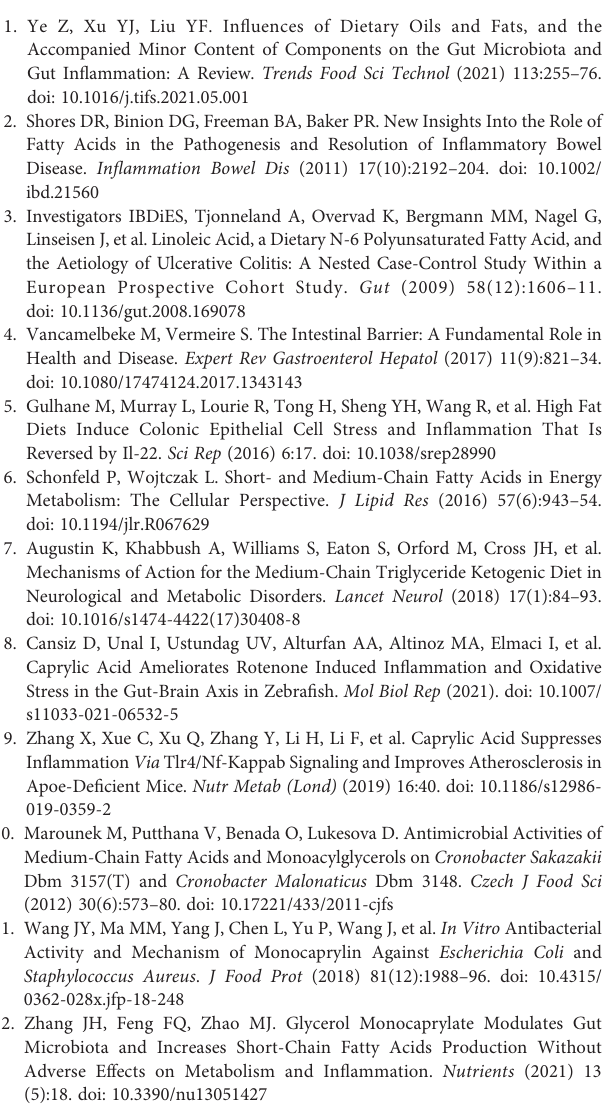
accumulation boxplot (F) of content fl ora both tended to approach the saturation plateau (n=4). The pro fi le of content fl ora (n=4) (G – O) . The histogram of relative abundance of phylum (G) and genus (H) (Only top 10 most abundant (based on relative abundance) bacterial phyla and genera were shown. Other phyla and genera were all assigned as ‘ Others ’ .) were calculated to portray the fundamental structure of content fl ora. The ratio of Firmicute to Bacteroidetes (n=3) (I) was calculated to portray the fundamental structure of gut content fl ora. Alpha diversity indices included the Simpson index (J) , the Shannon index (K) , the Chao 1 index (L) , and the abundance-based coverage estimator (Ace) index (M) were calculated to compare the community diversity and richness. The beta diversity analyses were performed on the weighted Unifrac distance matrix to analyze the extent of similarities in microbial communities, including the principal coordinates analysis (PCoA) (N) and UPGMA clustering (O) . Data of the relative mRNA of key antioxidation-related genes and the fold change of ROS were presented as means ± S.E.M. Means in each bar sharing the same superscript letter or absence of superscripts were not signi fi cantly different determined by Tukey ’ s test ( P ≥ 0.05). S.E.M.: standard error of means